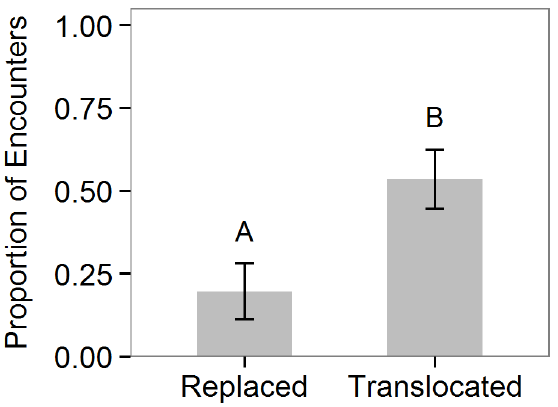
Figure 4. Response of Pseudomyrmexspinicola ants to replaced or translocated individuals of Piezogasterreclusus. Bars show the mean proportion ( 6 SE) of encounters in which Piezogaster reclusus was attacked when replaced on the host tree from which it was collected or translocated to a new tree with a different ant colony. Letters indicate significant differences from a binomial GLM.